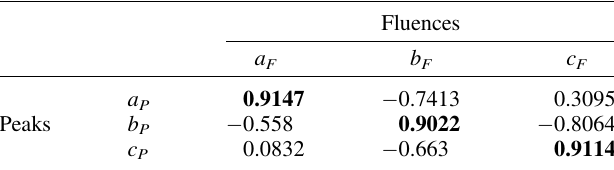
Table 2. Correlation values between spectral parameters of peak and fl